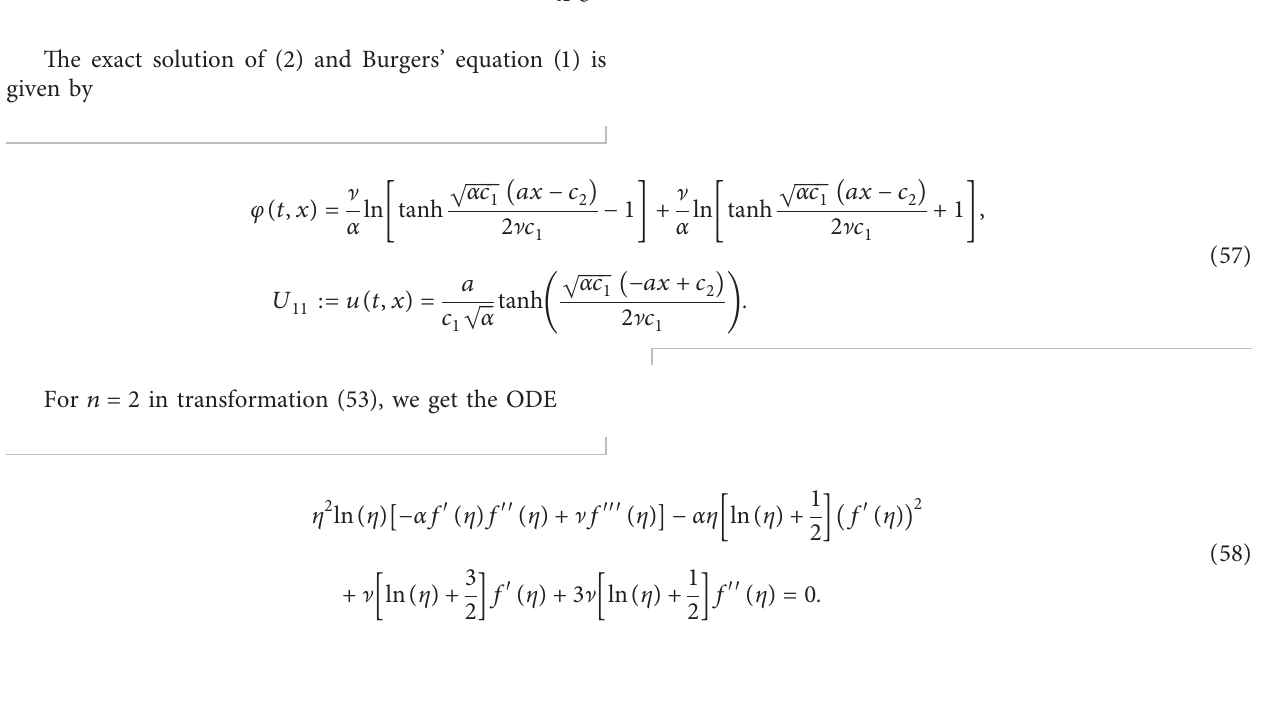
Figure 7: Plot of solution U